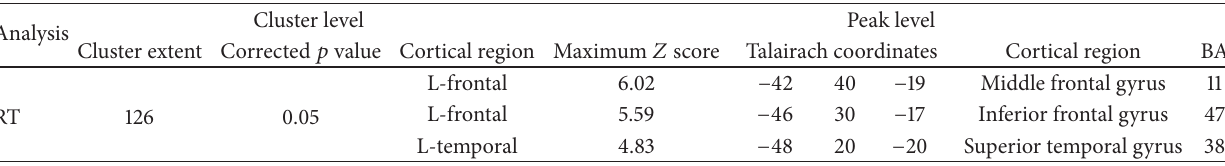
Table 2: Results of correlation analysis between mean reaction time (RT) and dopaminergic activity as assessed through 18 F-DOPA PET in de novo Parkinson’s disease